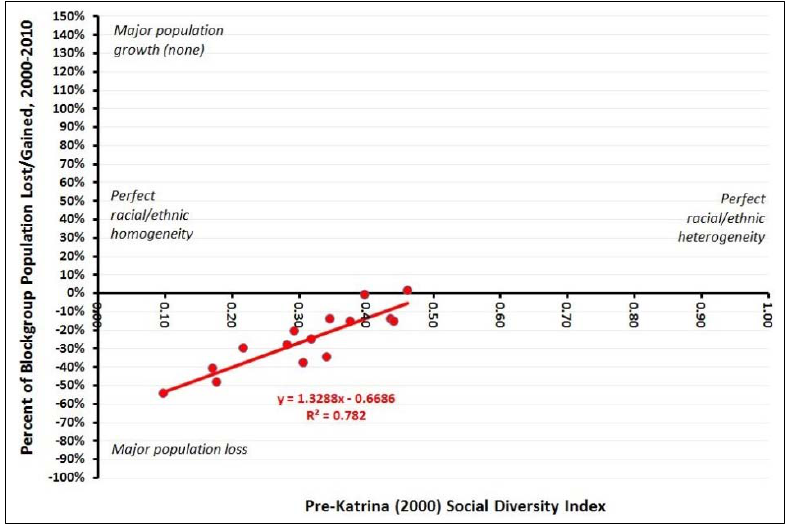
Figure 3. Relationships Between Pre-Katrina (2000) Social Diversity and Post-Katrina (2000–2010) Population Recovery.